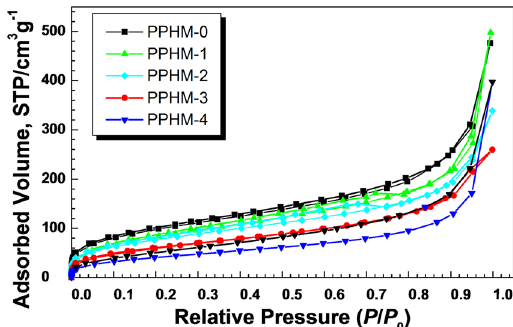
Figure 3. The nitrogen adsorption–desorption isotherms of the